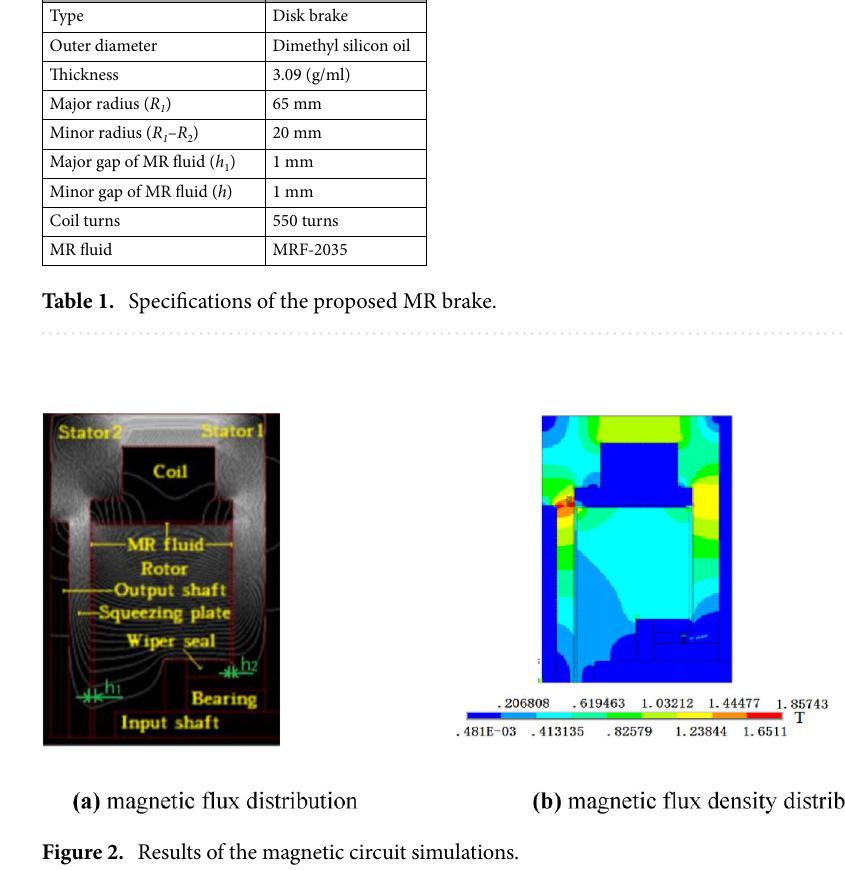
Figure 2. Results of the magnetic circuit simulations.